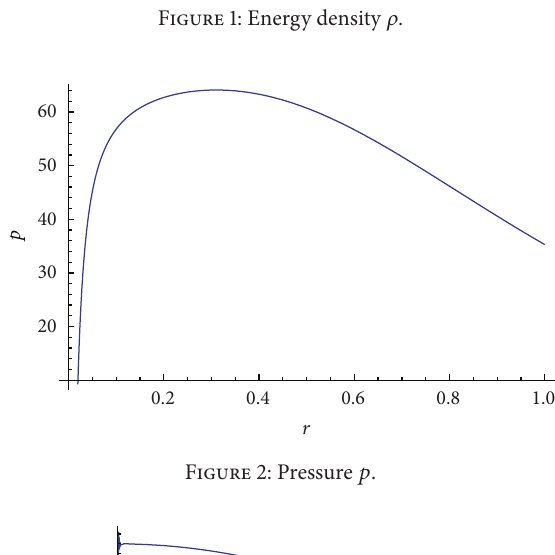
Figure 2: Pressure 𝑝 .